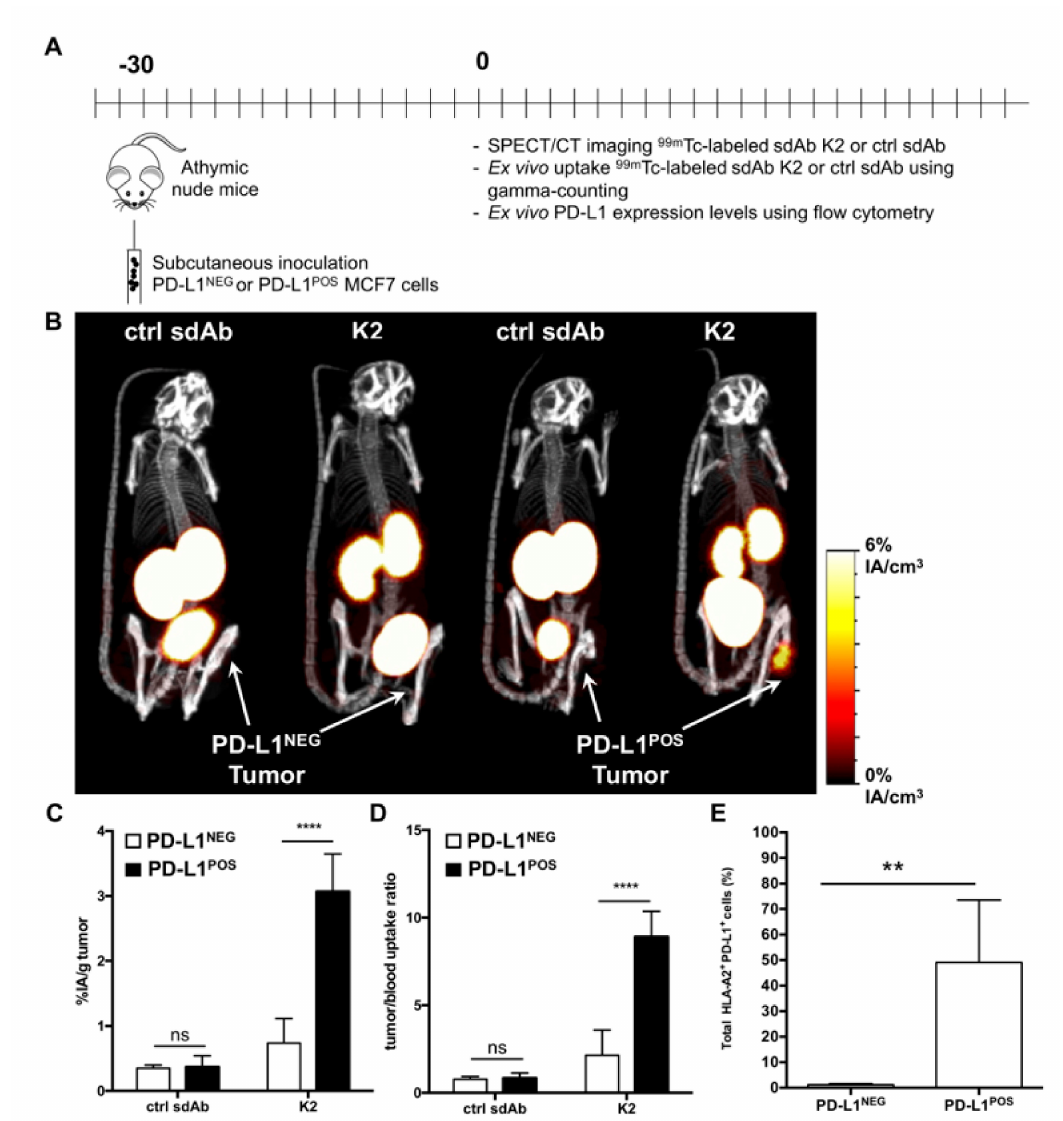
Figure 3. Radiolabeled sdAb K2 allows visualization of human PD-L1 POS breast tumors by nuclear imaging. ( A ) Scheme of the experimental setup. ( B ) SPECT / CT images showing the biodistribution of 99m Tc-K2 or 99m Tc-R3B23 (control sdAb) one hour after i.v. administration in athymic nude mice bearing PD-L1 NEG ( left ) or PD-L1 POS ( right ) MCF7 tumors ( n = 6). ( C , D ) Ex vivo analysis of the accumulation of 99m Tc-sdAbs in dissected PD-L1 NEG or PD-L1 POS MCF7 tumors ( C , expressed as %IA / g), and of tumor-to-blood uptake ratios ( D ), 80 min after i.v. radiotracer injection ( n = 6). ( E ) Percentage of human PD-L1 POS HLA-A2 POS cells in tumors dissected from mice that were s.c. implanted with parental MCF7 cells (PD-L1 NEG ) or PD-L1-transduced counterparts (PD-L1 POS ), as measured by flow cytometry analysis of tumor single cell suspensions ( n = 6). ** p < 0.01, **** p <